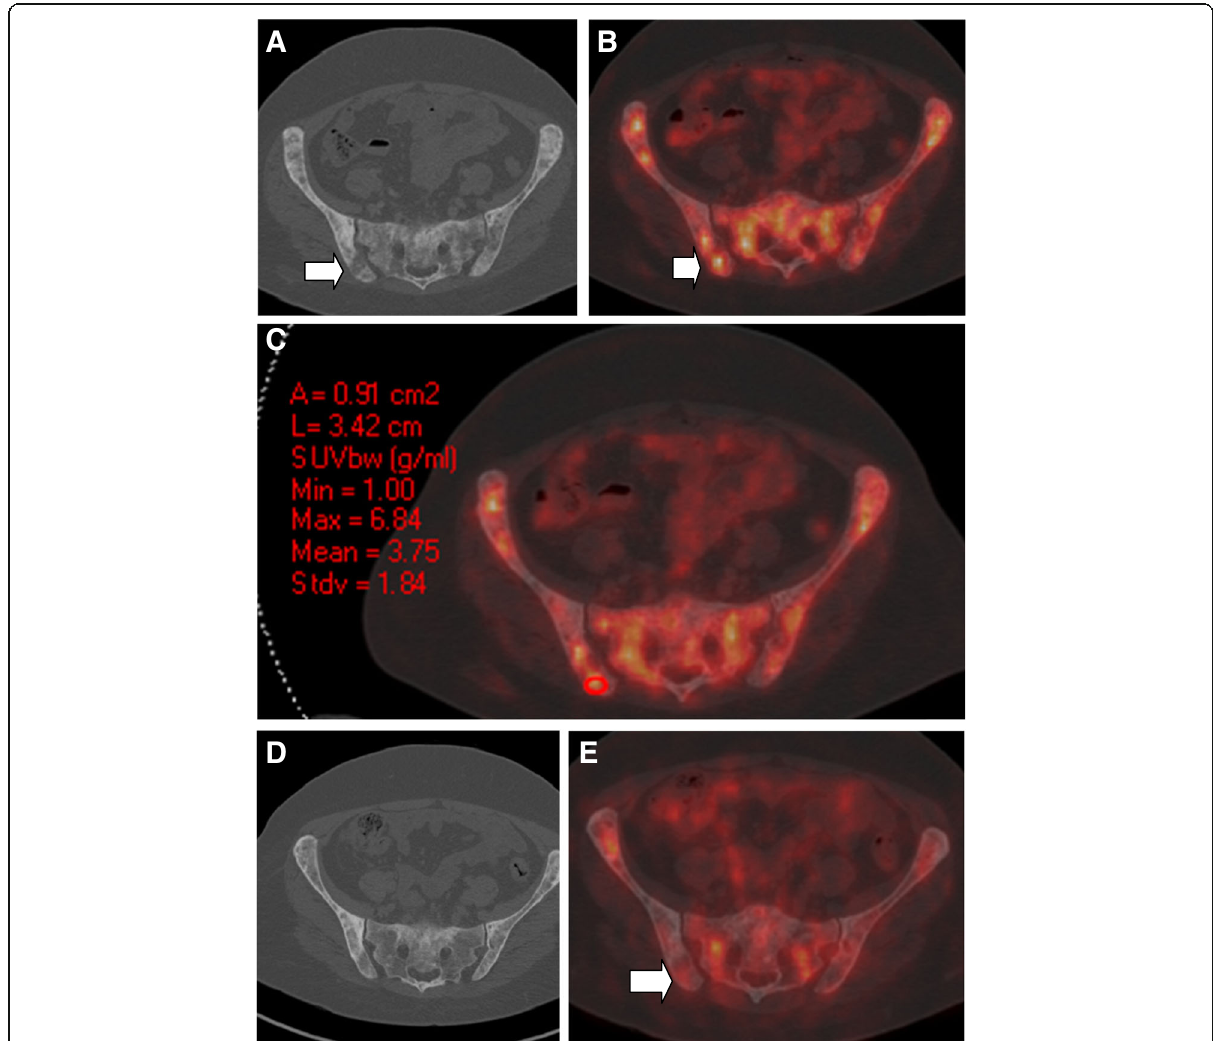
Fig. 1 Follow up post chemotherapy regimen for patient with cancer breast and isolated bony metastatic disease a axial CT bone window and b, c corresponding PET/CT fused image showing multiple iliac and sacral lesions, the lesion with highest SUV max value was the lytic lesion targeting the posterior asepct of the right iliac bone SUV max: 6.8 (arrow in b ). d Axial CT pelvis and e corresponding PET/CT fused image 6 months following the chemotherapy; the lesion shows relative increase density in the CT image and signifnact decrease in FDG uptake (arrow); the SUV max value reaching 2 treatment